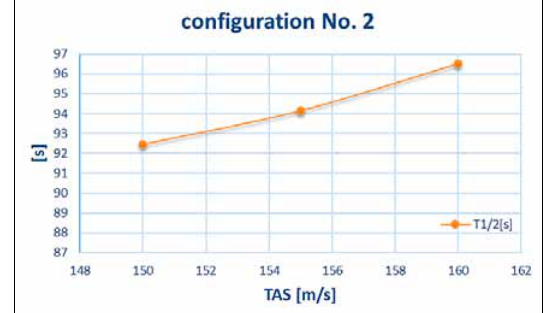
Fig. 16. The time to half damping for the spiral mode